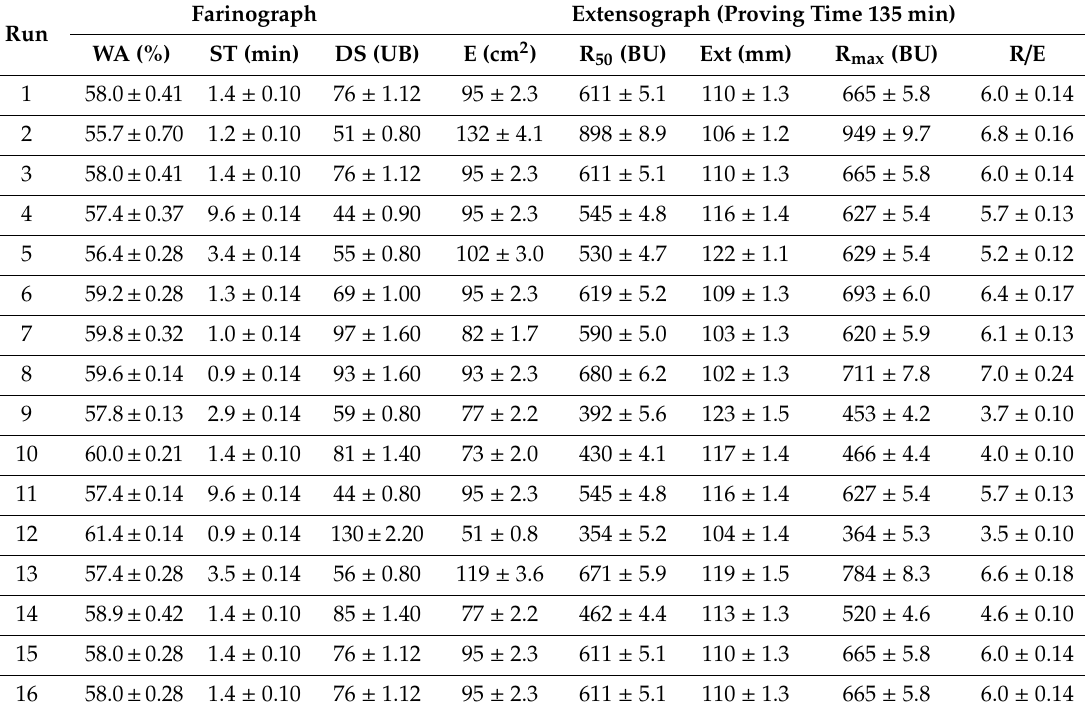
Table 2. The e ff ects of di ff erent levels of independent variable addition on dough rheological properties during mixing and extension of sea salt–dry sourdough–fermented sugar